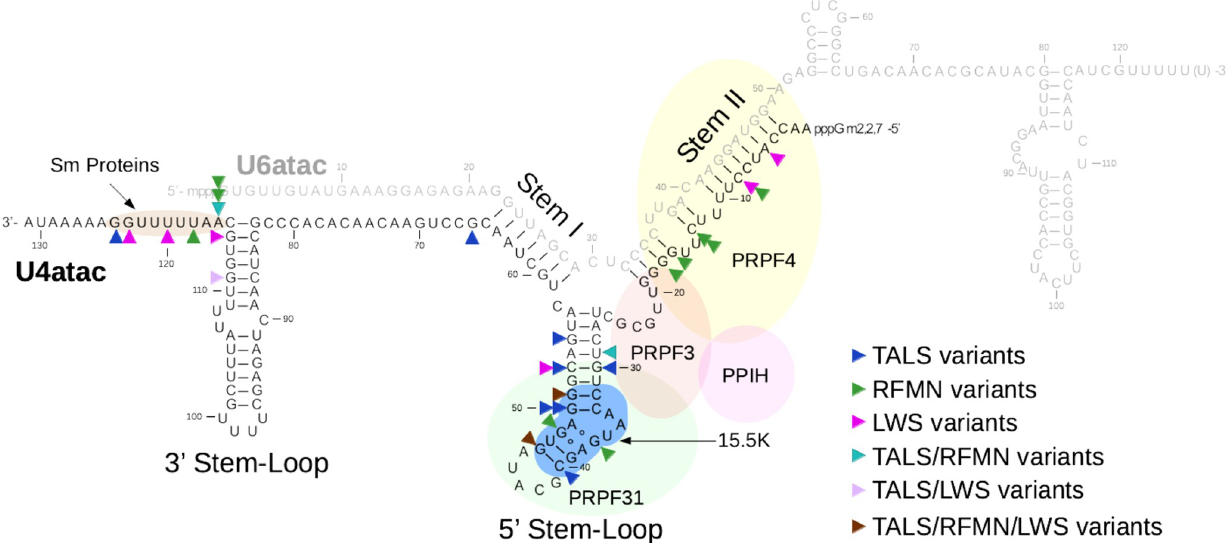
Fig 1. U4atac nucleotides mutated in TALS, RFMN and LWS patients. The U4atac/U6atac bimolecule is represented, as well as its main interacting proteins (15.5K, PRPF3, PRPF4, PRPF31, PPIH, and the Sm proteins). Arrowheads point to the mutated nucleotides observed in TALS, RFMN and/or LWS. There are five nucleotides for which more than one substitution was identified (more than one arrowhead in the figure). The 85 nt-duplication (n.16_100dup) is not shown.